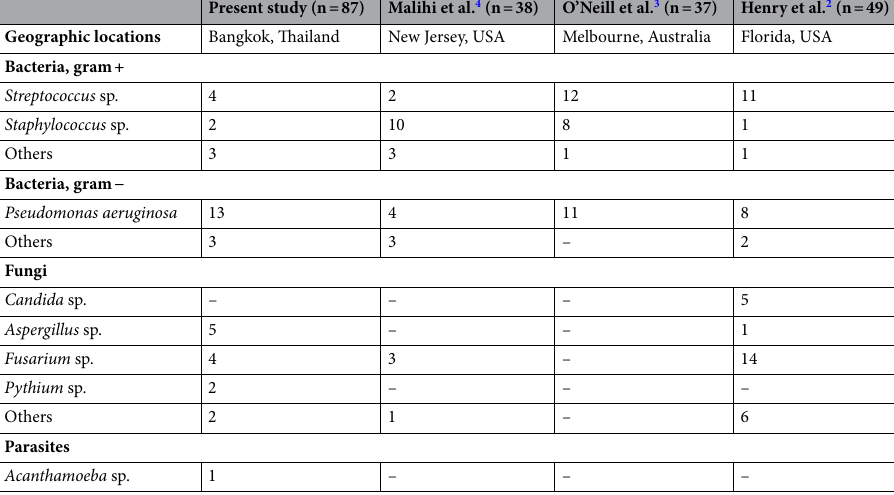
Table 2. Identified causative pathogen species of the present study in comparison with other previous